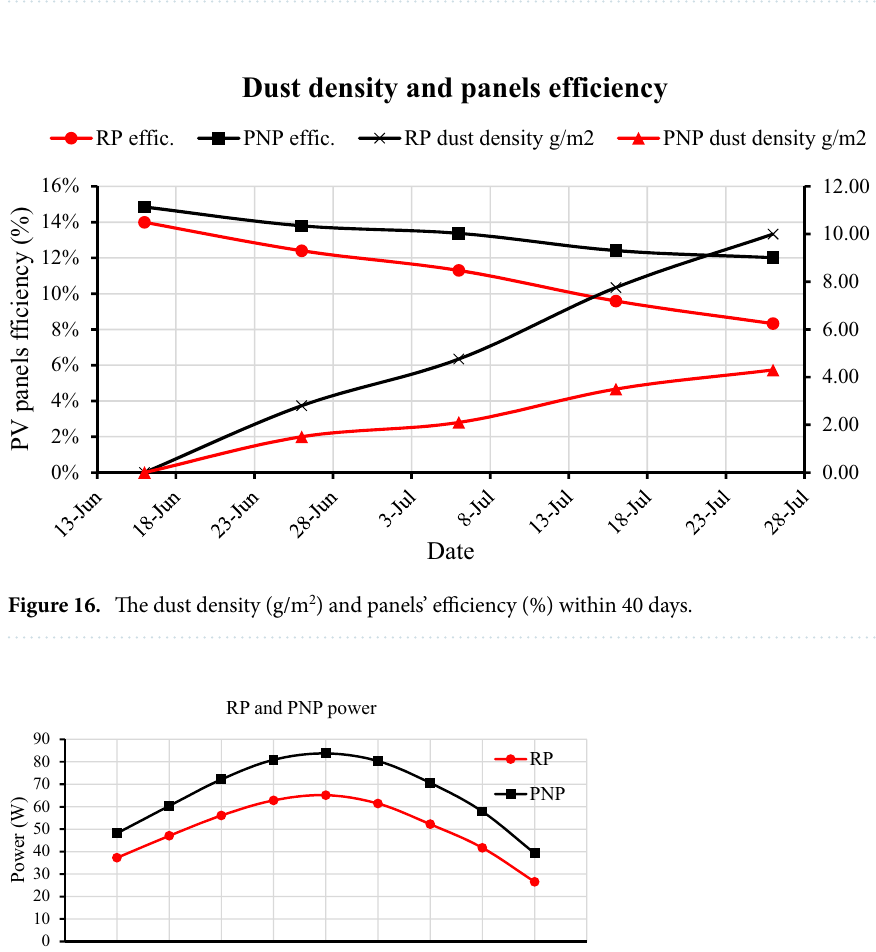
Figure 15. The RP and PNP temperature within 40 days.